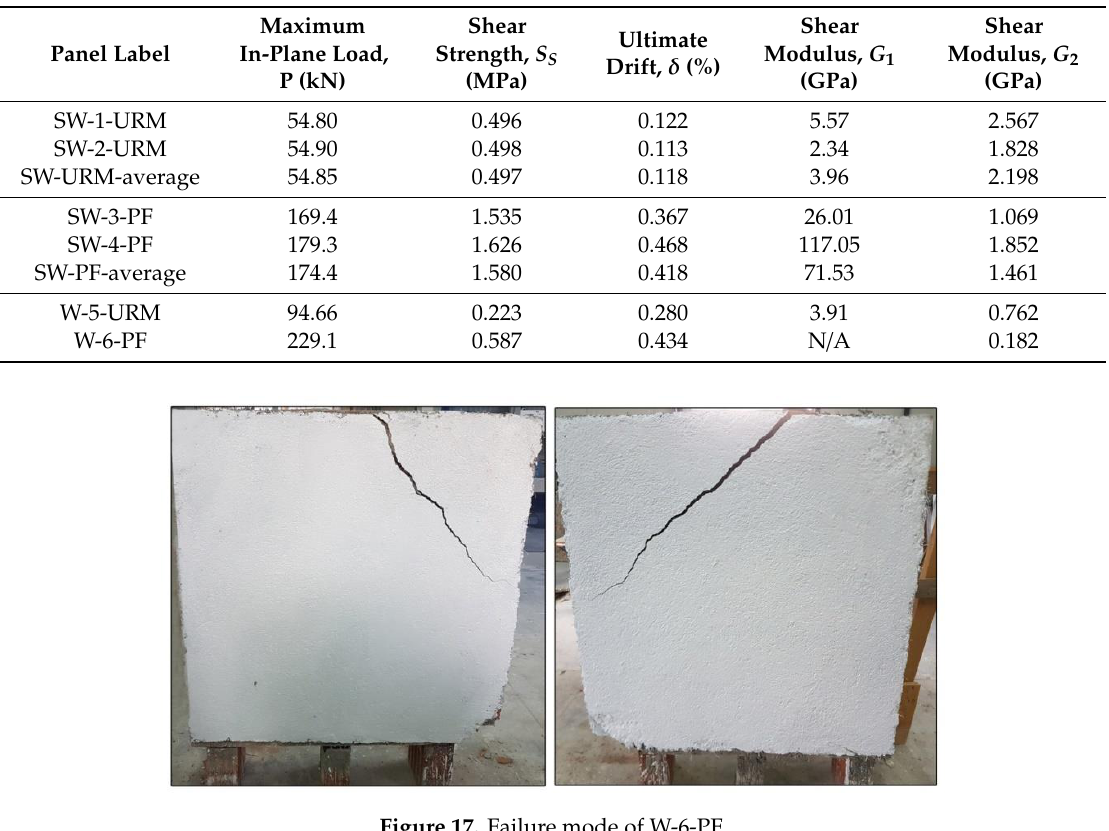
Figure 17. Failure mode of W-6-PF.